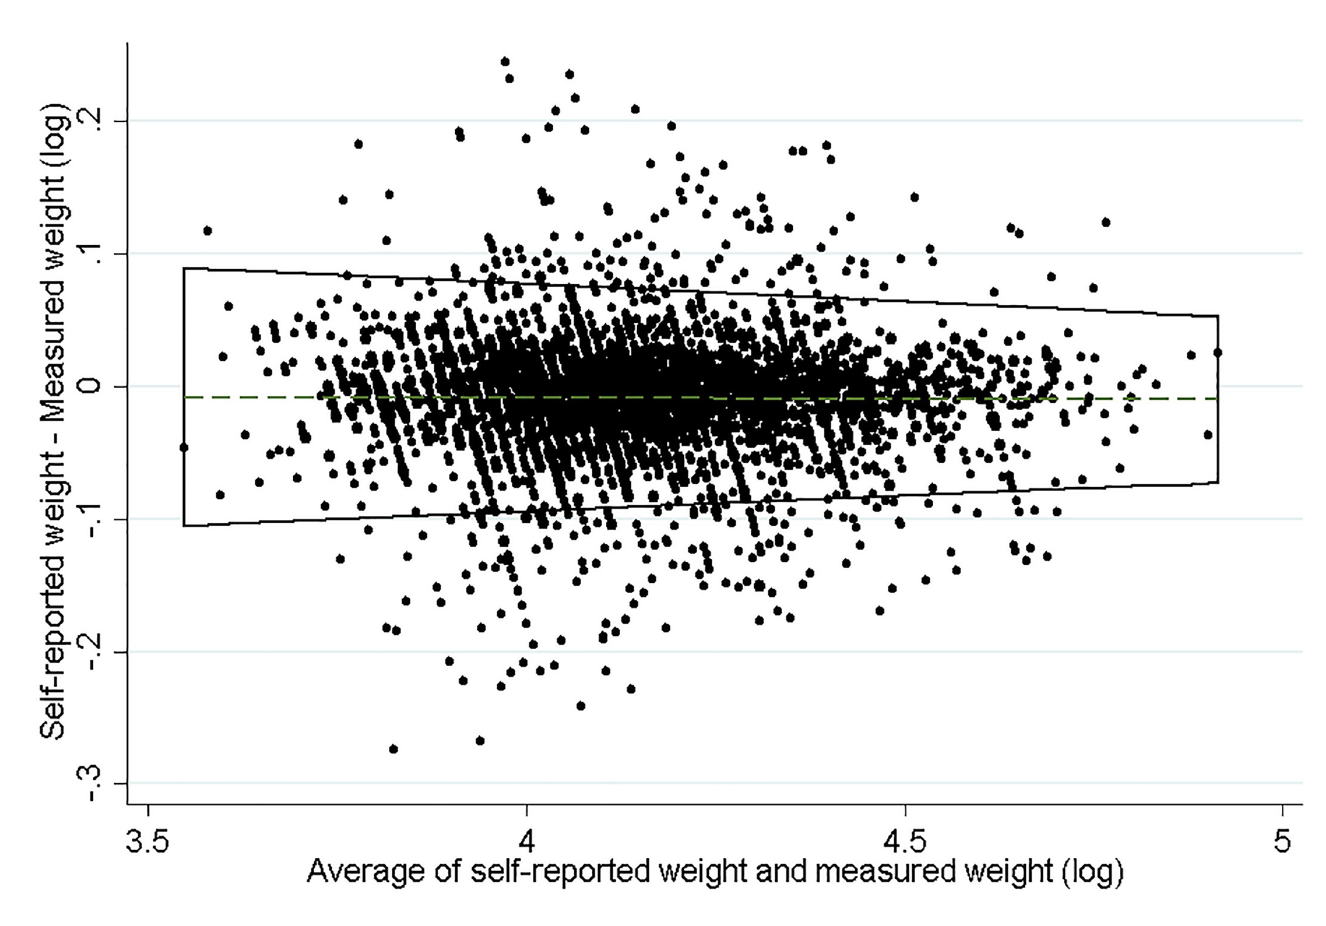
Fig 1. Bland-Altman plot for analysis of agreement between self-reported and measured weight in 18 to 49-year-old women.